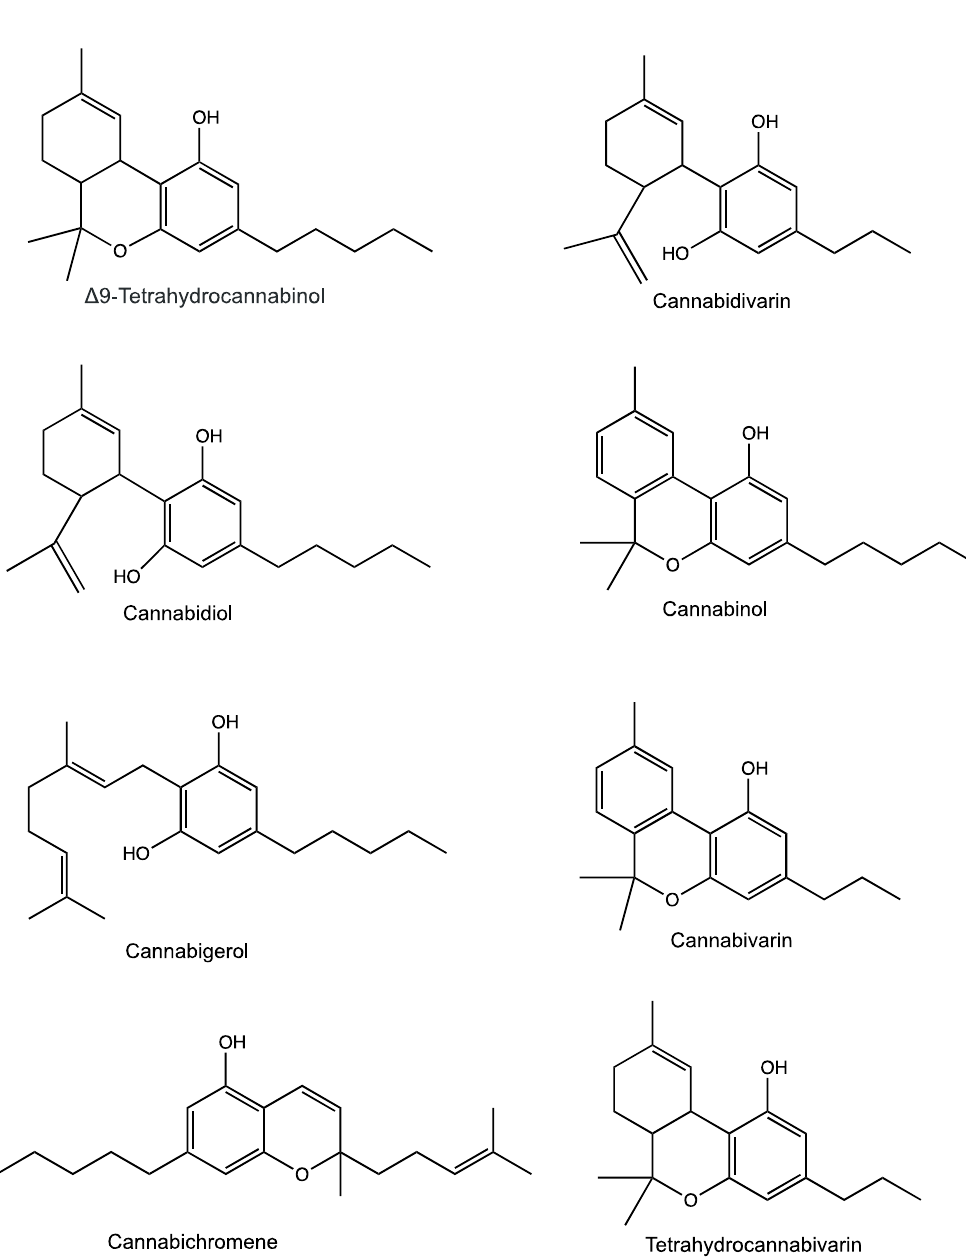
Figure 1. Structure of various cannabinoids found in the Cannabis